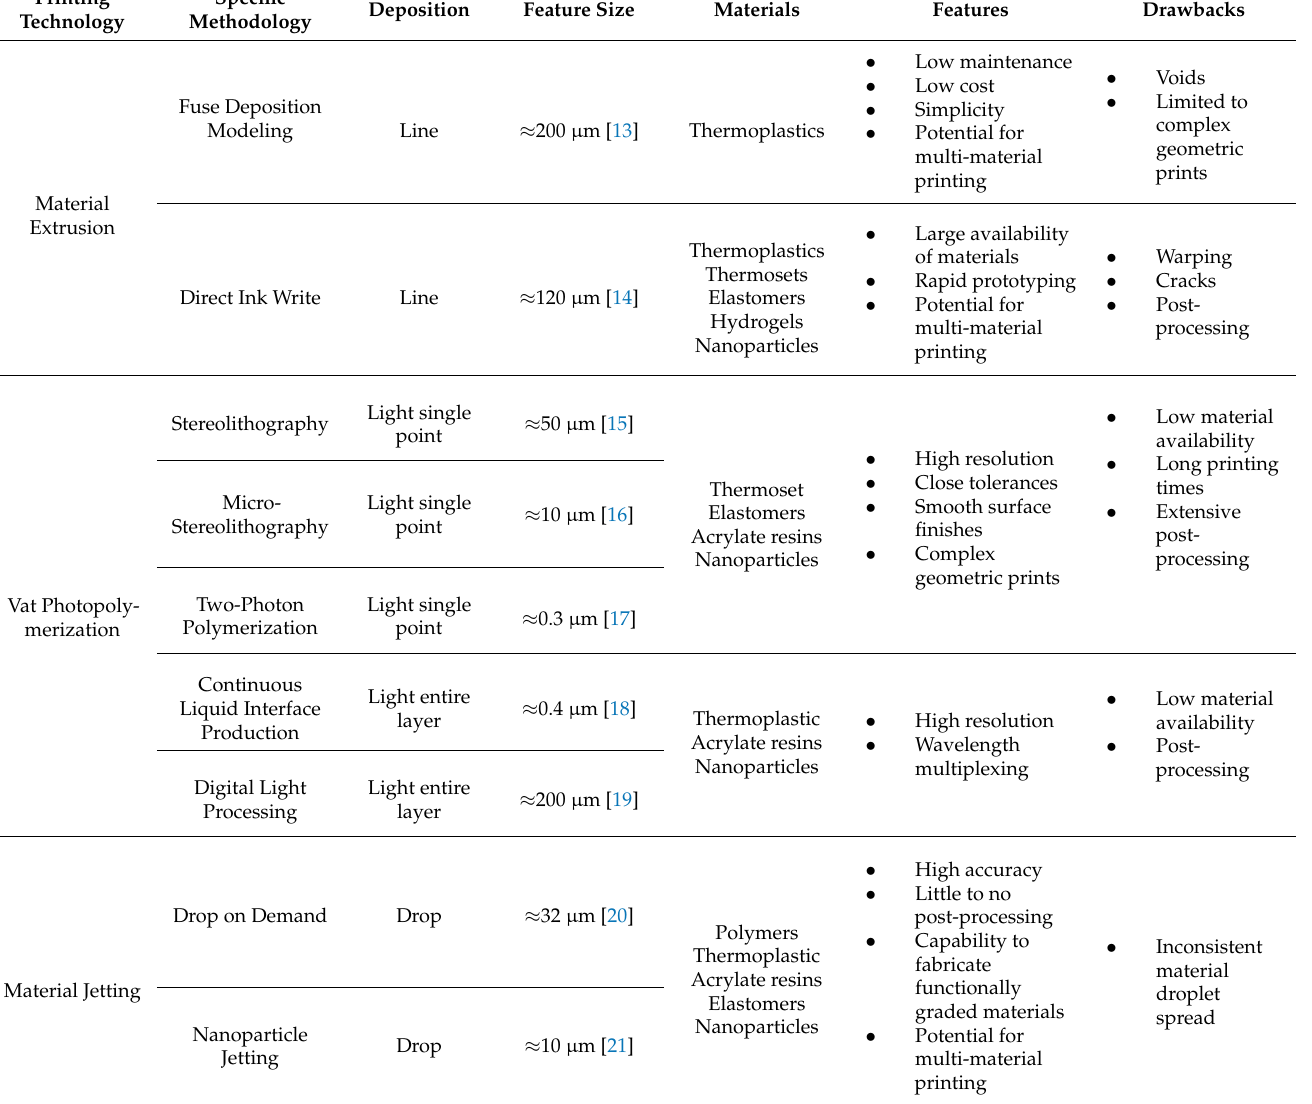
Table 1. Summary of advantages and disadvantages of additive manufacturing methods and techniques used for the fabrication of soft functional